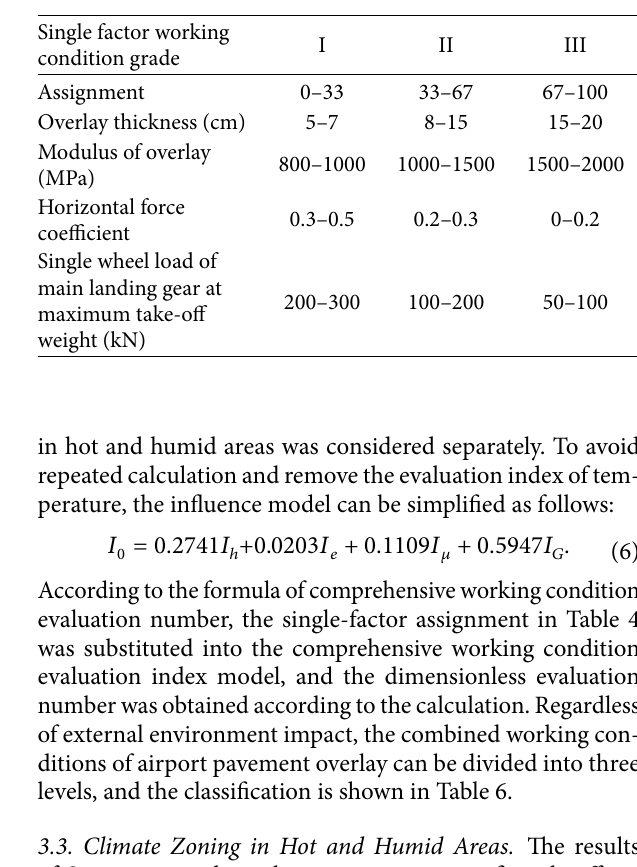
Table 4: Classification of single-factor working condition of